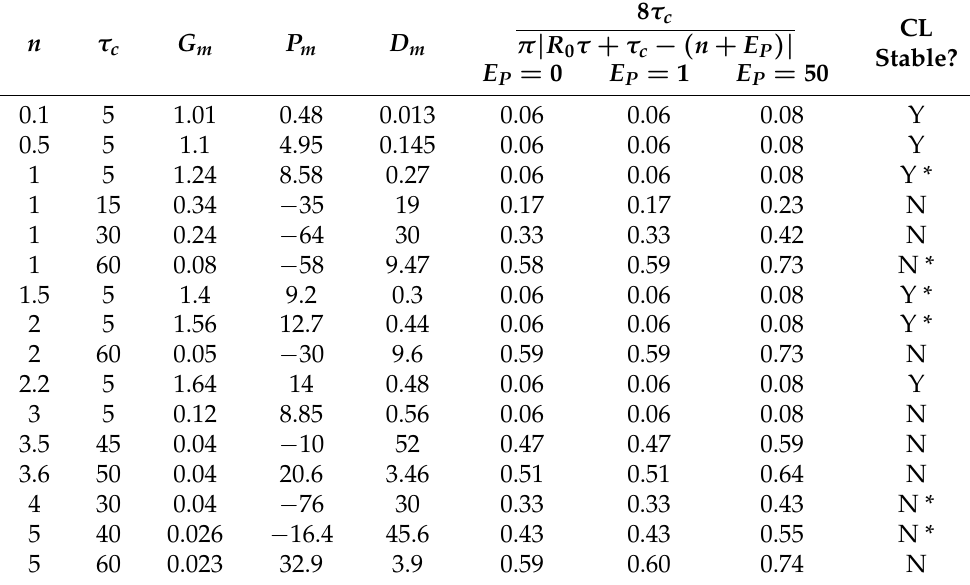
Figure 9. Frequency response of the linear component: stable for ( n , τ c ) ∈ { ( 1,5 ) , ( 1.5,5 ) , ( 2,5 ) } and unstable for ( n , τ c ) ∈ { ( 1,60 ) , ( 4,30 ) , ( 5,40 ) } . Table 2. Frequency analysis results ( R 0 = 40). The frequency responses of the linear components for the rows marked with * are presented in Figure